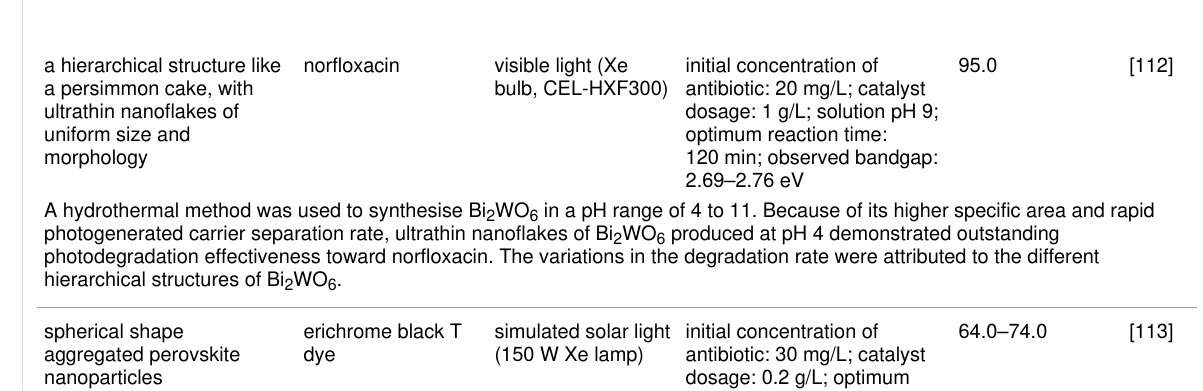
Table 3: Bi 2 WO 6 -based nanostructured materials for remediation of antibiotics and dyes.